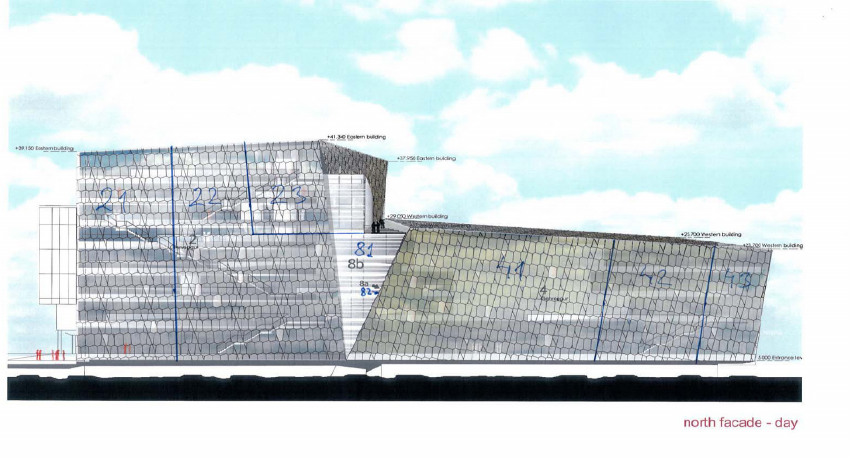
Figure 5, Area 23 in the north elevation of the Concert Hall.